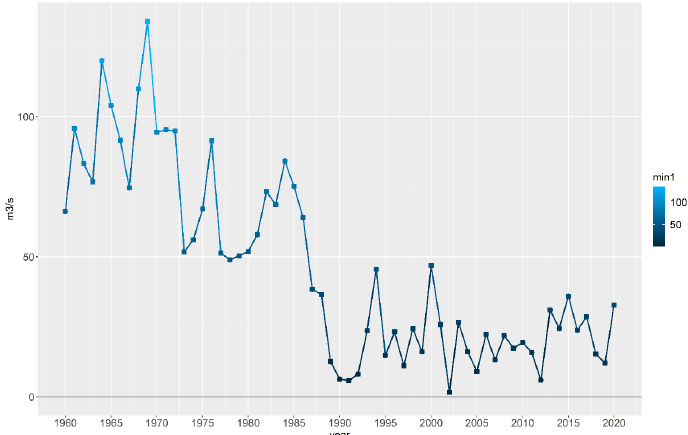
Figure 9. Hydrograph of annual minimum 1-day flow index.